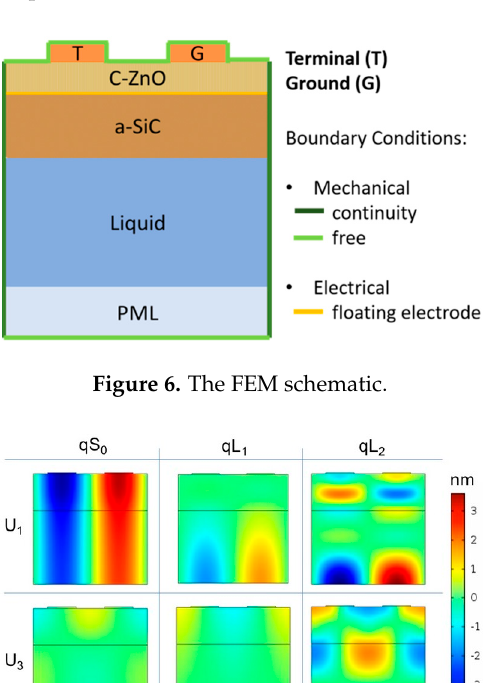
Figure 5. The field profile and in-plane power flow per unit area for the qL 2 mode propagating along a-SiC and ZnO thicknesses equal to 5 and 2.5 µm, for λ = 8.8 µm.